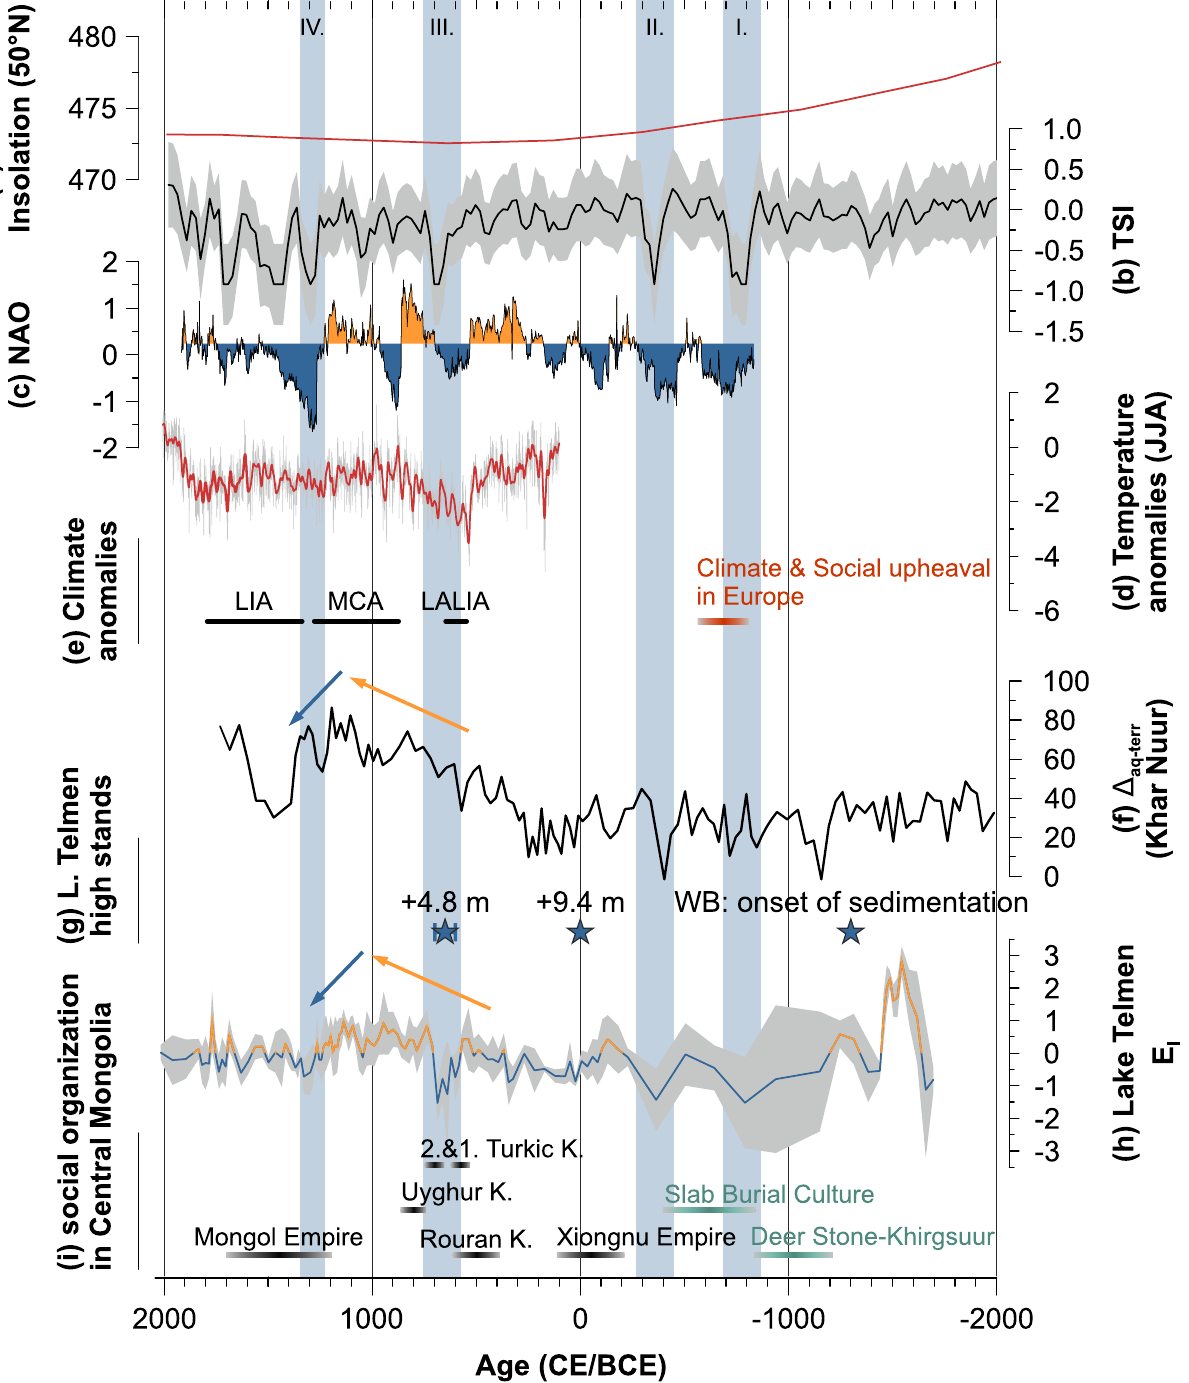
Figure 4. Late Holocene hydrological changes at Lake Telmen. ( a ) 50° N summer insolation [Wm −2 ] 88 , ( b ) total solar irradiance [Wm −2 ], gray-shaded area = 1σ uncertainty 44 , ( c ) North Atlantic Oscillation (NAO) index 58 [–], ( d ) reconstructed June, July, and August temperature anomalies from the Russian Altai (°C, with reference to 1961–1990) 33 . Bold red line shows a 21 year moving average, ( e ) climate anomalies during the Late Holocene: Late Antique Little Ice Age (LALIA), Medieval Climate Anomaly (MCA), and Little Ice Age (LIA) after Büntgen et al. 33 and the period of social upheaval in Europe 68,71 , ( f ) Δ aq-terr — the offset between δ 2 H n -C23 (aquatic) and δ 2 H n -C31 (terrestrial) indicating lake water evaporative enrichment 30 [‰ vs. VSMOW], ( g ) blue stars show lake level high-stands at Lake Telmen of 4.8 m and 9.4 m above the current lake level and the onset of sedimentation in the western basin (WB) 22 , ( h ) evaporation index (E I ) [–], gray-shaded area = standard deviation, ( i ) social organization and duration of important Mongolian steppe cultures: Deer Stone–Khirgsuur complex (DSK), Slab Burial Culture 72 , the Xiongnu 10,75 , the Rouran Khaganate 10 , the first and second Turcik Khanganate 10,76 , the Uyghur Khanganate 36 and the Mongol Empire 10,13 . Vertical blue bars indicate distinct solar minima at ~ 800 BCE (I.), 400 BCE (II.), as well as ~ 700 CE (III.) and ~ 1300 CE